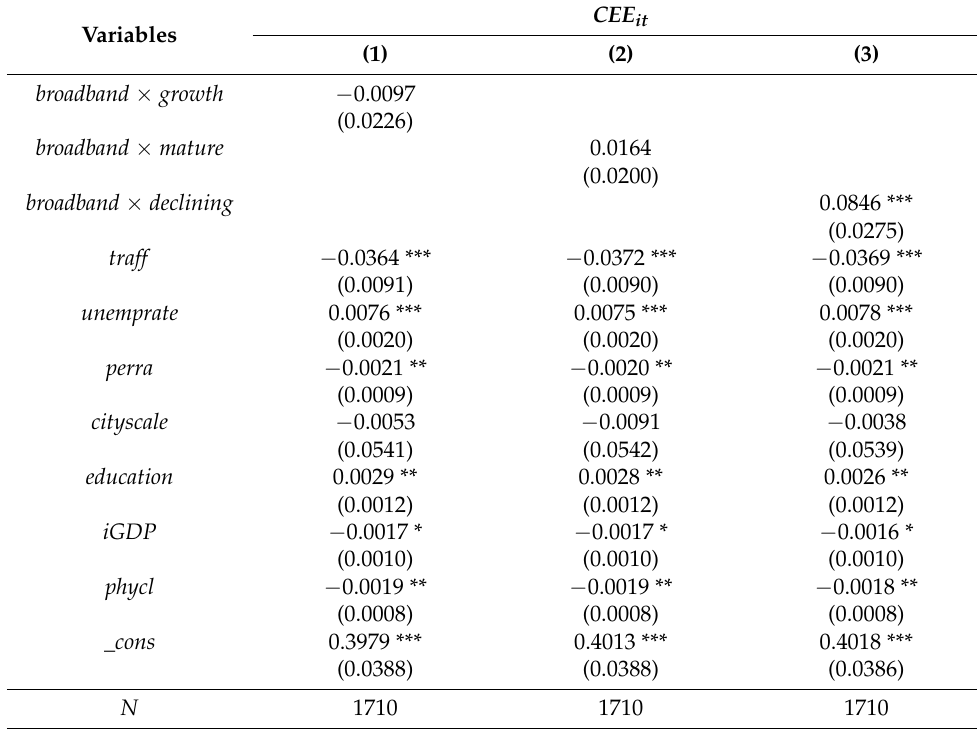
Table 7. Heterogeneity regression results for different city